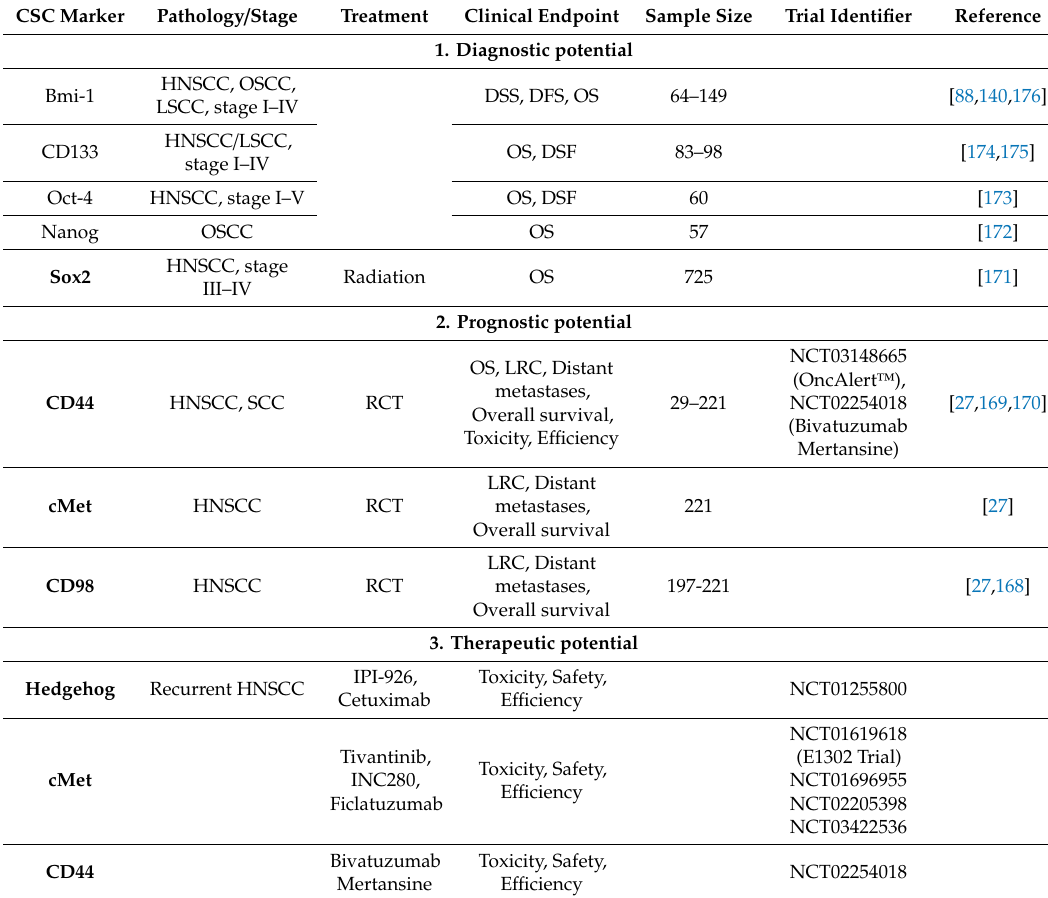
Table 4. CSC-based clinical trials in HNSCC (diagnostics, prognosis and treatment) (selected). CSC